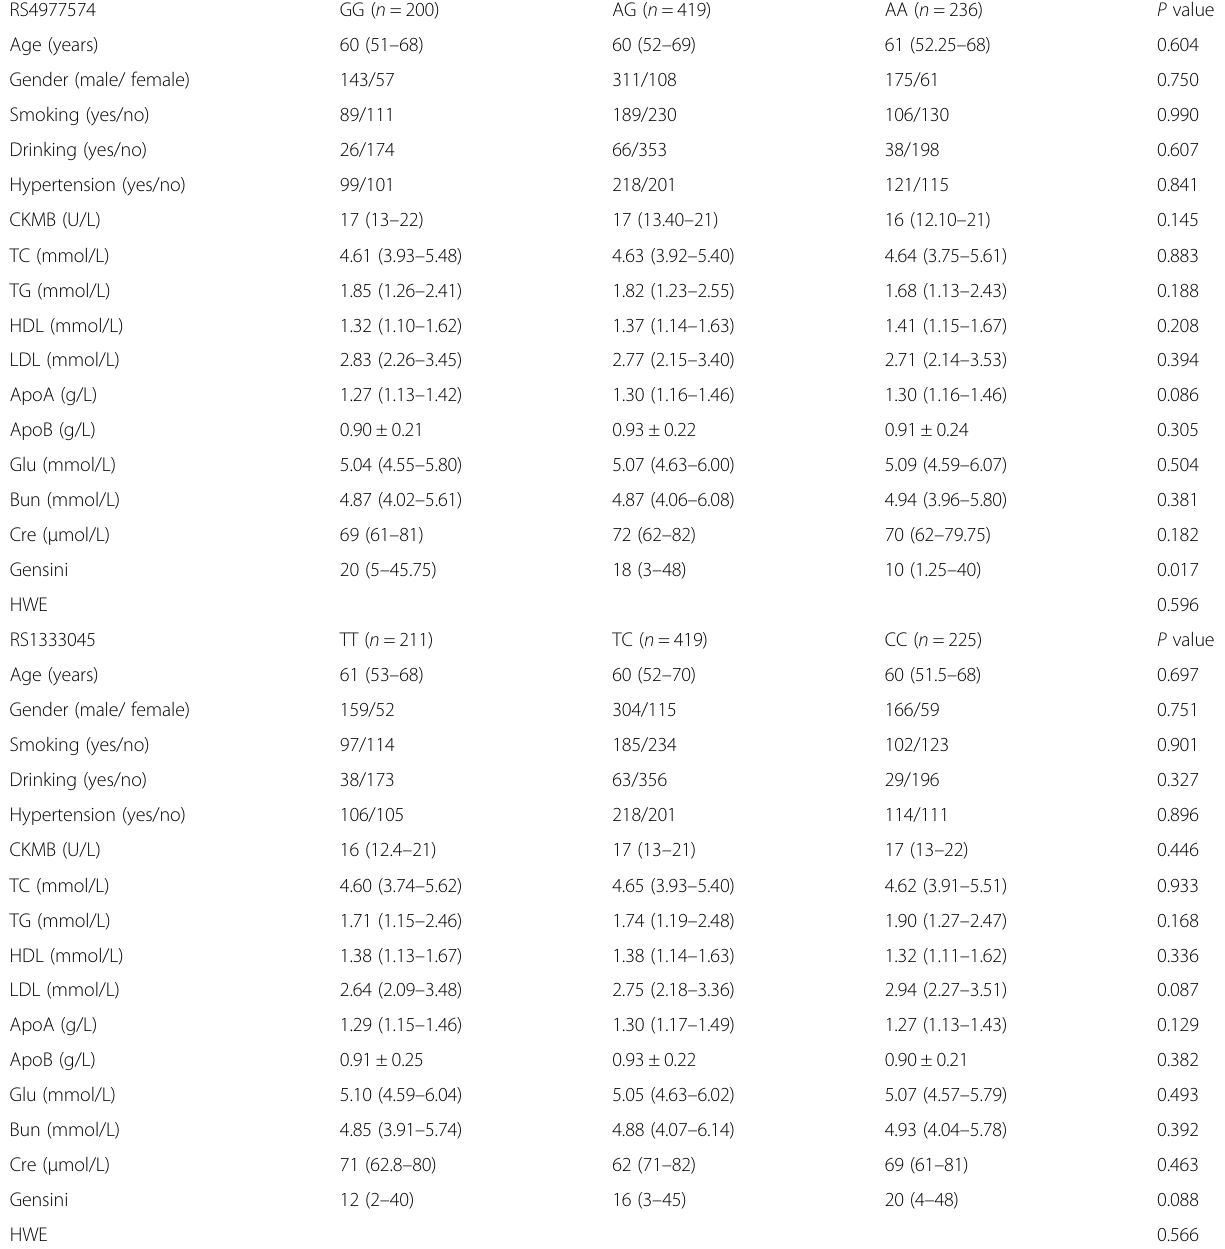
Table 2 Clinical parameters distributed in different